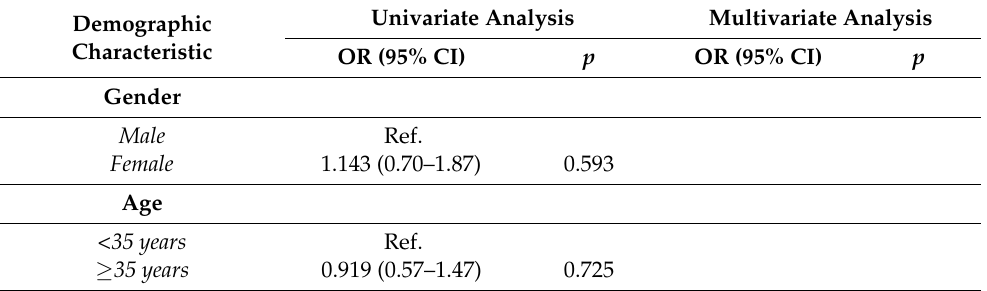
Table 5. Logistic analysis of influential factors for the non-prescribed purchase of